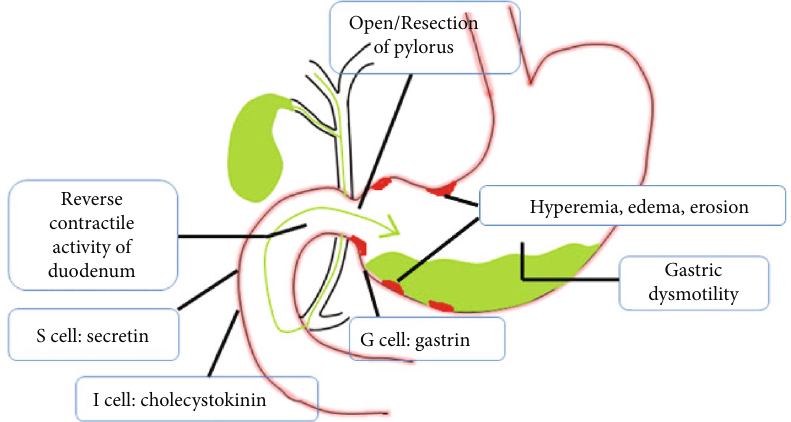
Figure 1: Pathogenesis of bile re fl ux gastritis. Re fl ux — gastroduodenal dysmotility, disorder of gastroduodenal hormones, and surgical resection of pylorus. In fl ammation (hyperemia, edema, erosion) — stimulation of bile acids, lysolecithin, and so